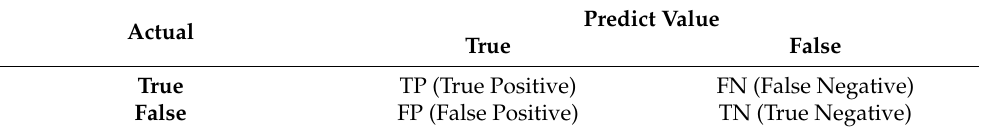
Table 1. Confusion